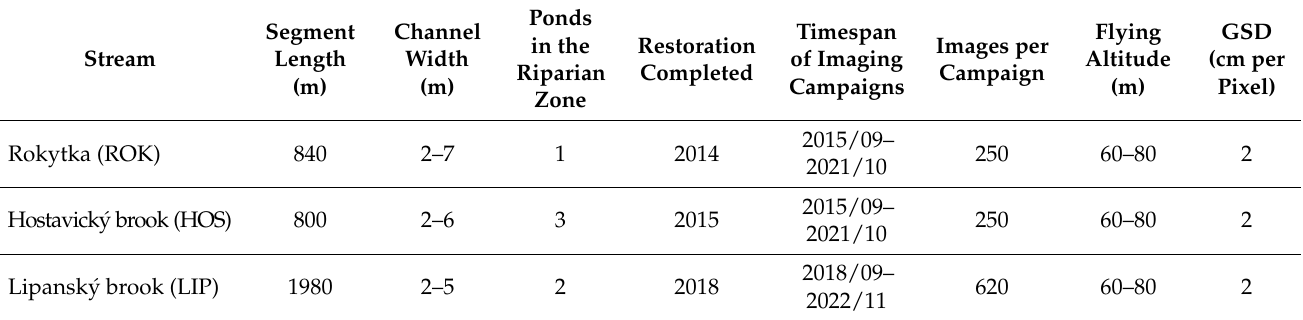
Table 1. Parameters of UAV monitoring